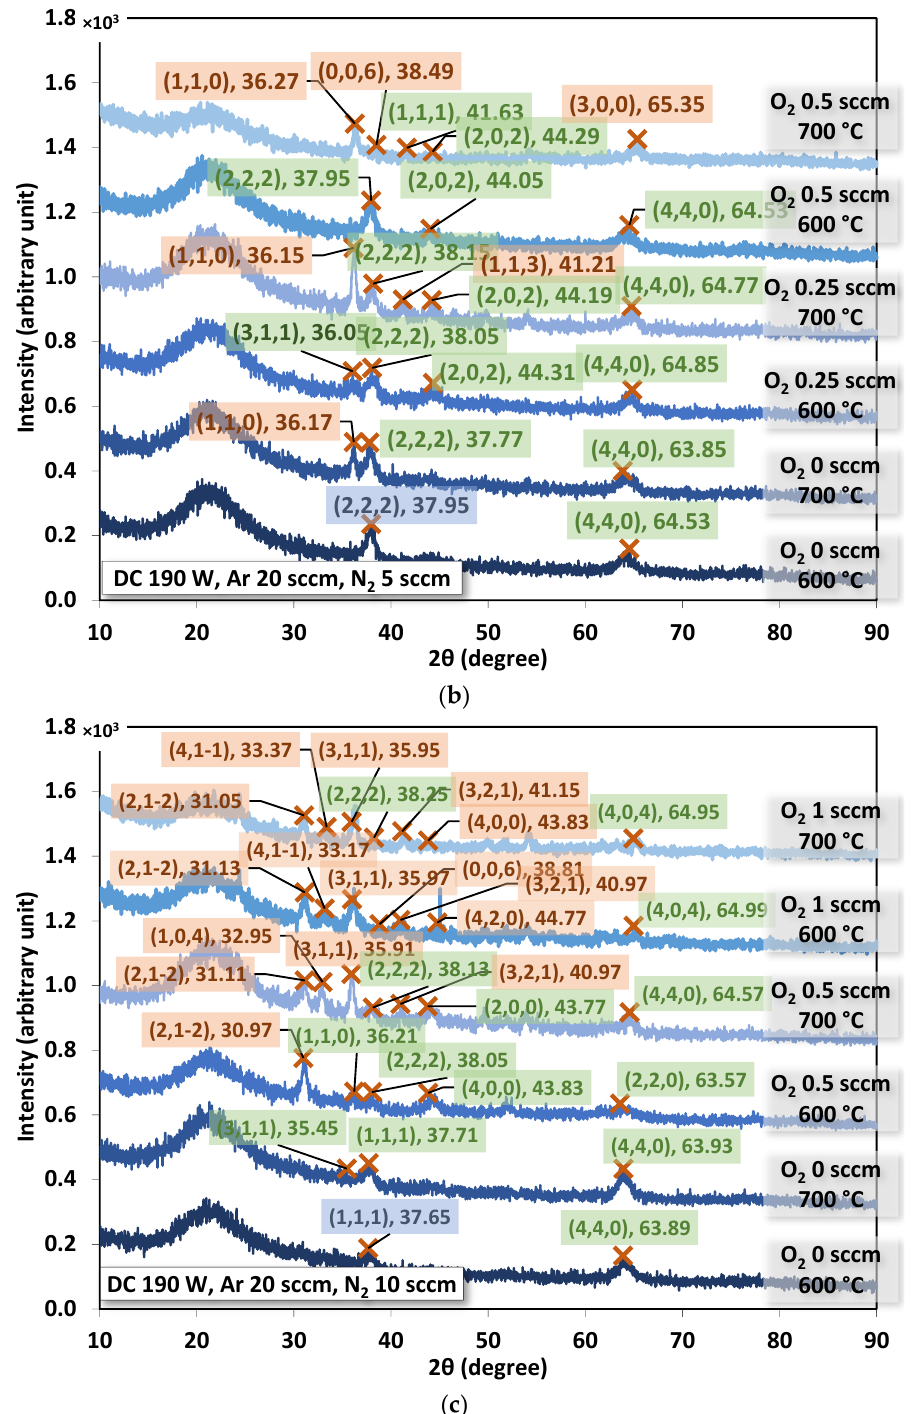
Figure 3. XRD of annealed films under different temperatures for different nitrogen supplies during deposition. ( a ) N 2 3 sccm, ( b ) N 2 5 sccm, and ( c ) N 2 10 sccm. (The color code is vanadium nitrides, vanadium oxynitrides, and vanadium oxides). For each nitrogen flow rate, there exists an optimal oxygen flow to produce vana- dium oxynitride films. One optimal flow rate is found to be about ~1/20 of the nitrogen flow rate in the current study. For example, if N 2 = 3 sccm, then O 2 = 0.15 sccm can yield vanadium oxynitrides, almost for sure.